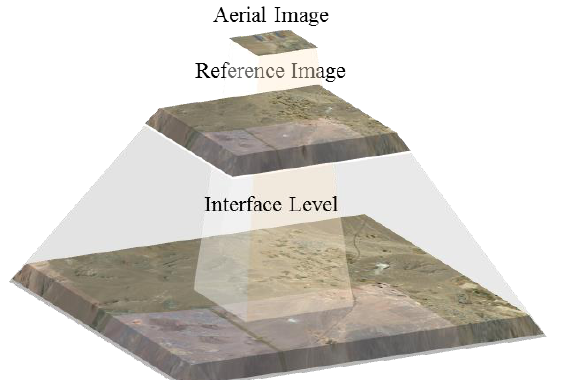
Figure 3. The simulation procedure